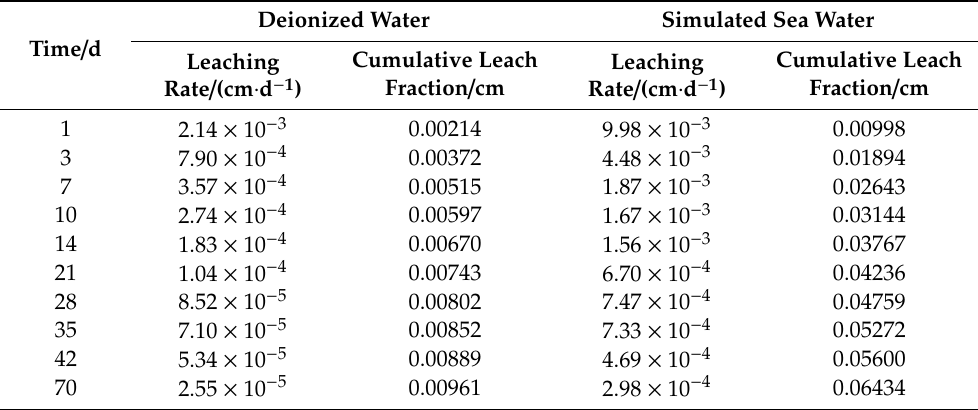
Table 4. Leaching rate and cumulative leach fraction of the M–S–H cement-solidified body with 0.8 wt. % Cs under different leaching fluids.